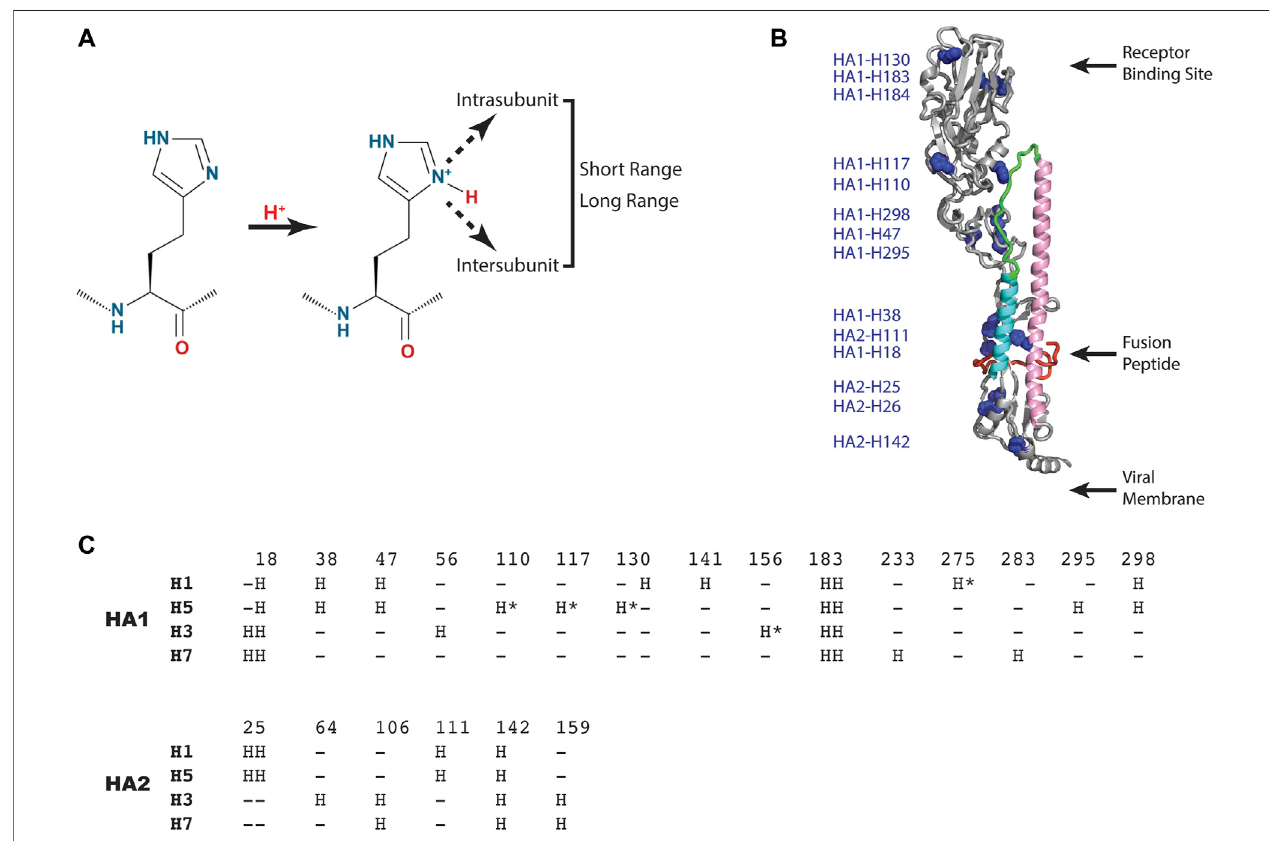
FIGURE 3 | HA residues implicated in the pH trigger. (A) Schematic representation of the type of interactions that could occur upon protonation of select histidine sidechains. (B) Distribution of histidine residues observed in a representative HA (H5 HA; pdb (cid:1) 2FK0). The coloring scheme of the backbone is that of Panel 1 with histidinesidechainsshownasbluespheres.Forsimplicity,onlyonemonomeroftheHAtrimerisshown. (C) Sequencealignmentofconsensushistidineresiduesfoundin representative Group 1 and 2 HA of in fl uenza A using CLUSTAL O (1.2.1). Sequences: H1 HA (A/Puerto Rico/8/1934 H1N1); H5 HA [A/Viet Nam/1203/ 2004(H5N1)], H3 HA [A/Brisbane/10/2007(H3N2)] and H7 HA [A/Netherlands/219/2003(H7N7)]. The consensus histidines are found in > 99% of the in fl uenza A sequences deposited in the NCBI in fl uenza virus data base and the nonconsensus histidines are denoted by